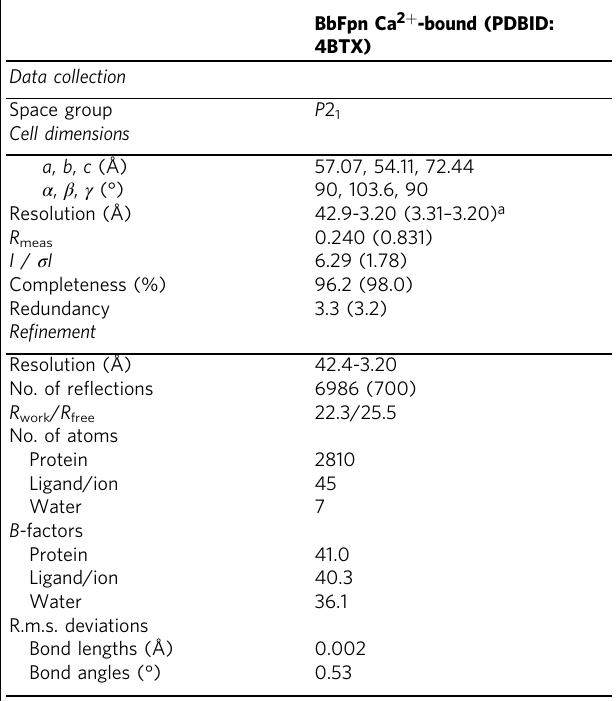
Table 1 Data collection and re fi nement statistics (molecular replacement)